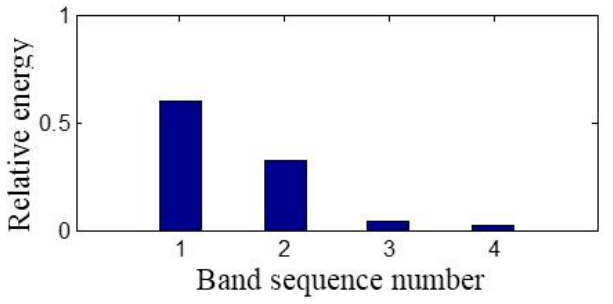
Figure 8. The sensor-dependent signal’s relative energy distribution in level 2.